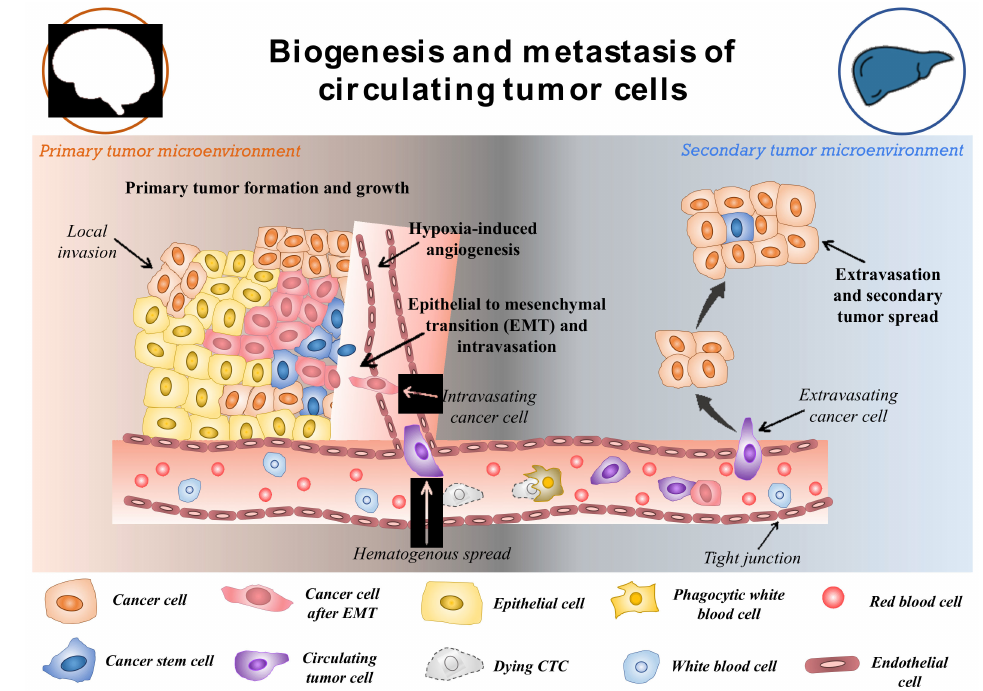
Figure 2. Schematic representation of potential biogenesis and the transport mechanism of circulating tumor cells. Reproduced from